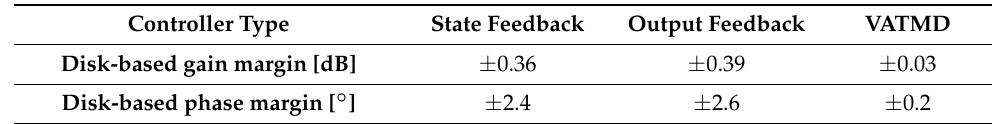
Figure 17. Open-loop and closed-loop receptance h 3,3 (j ω ) : comparison with state-feedback, output- feedback and VATMD. Table 11. Robustness margins of the closed-loop system for different